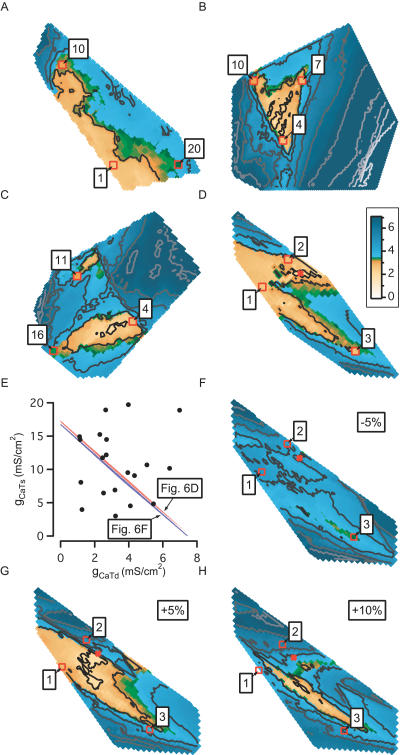
Two-Dimensional Views of Some Hyperplanes of the Parameter Space(A–D) Some typical projections onto the (gNaPs, gNaFs) plane of hyperplanes defined by triplets of individuals. The fitness values of all points belonging to these hyperplanes are color scaled. The three original individuals of each hyperplane are labeled and highlighted by a red square. Grey lines delimitate iso-fitnesses.(E) The hyperplane of (D) is shown in red in projection onto the (gCaTs, gCaTd) plane. The 20 best individuals are represented by points. A blue hyperplane is drawn parallel to the red one. It is defined by adding to the red hyperplane points 10% of the sdv of all solutions in every dimension. Note that individuals that are in between these hyperplanes in this projection can be very far away in other dimensions.(F–H) Parallel hyperplanes of (D), with the same projection. These hyperplanes are obtained by adding respectively −5%, +5%, and +10% of sdv to the points belonging to the hyperplane shown in (D). The red cross mark the region of best fitness in the original hyperplane (D).